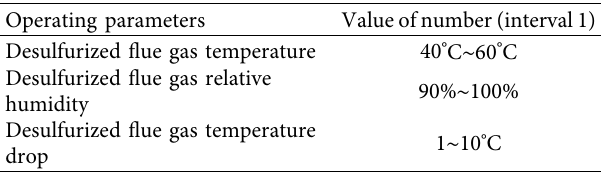
Figure 5: Numerical calculation results of supersaturation degree. (a) Influence of desulfurized flue gas relative humidity and temperature drop. (b) Influence of desulfurized flue gas temperature and temperature drop. Table 1: Typical conditions of thermodynamic